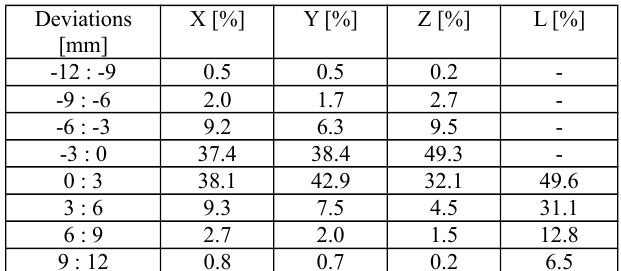
Table 1. Percentage number of points for specified deviations - sphinxes